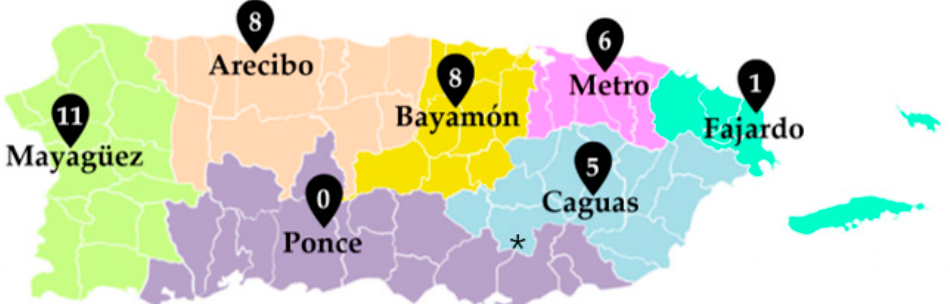
Figure 2. Geographic distribution of PCD pathogenic variants in Puerto Rico. Of the seven designated health regions in Puerto Rico, Mayagüez showed the highest frequency in pathogenic variants with 11 subjects. Two cases presented two different pathogenic variants in the same subject. * PCD clinic location.